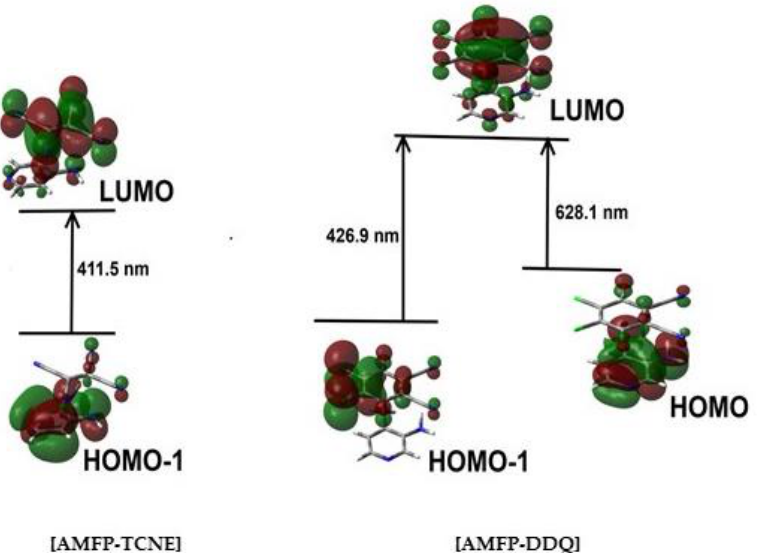
Figure 14. The molecular orbitals contributed to the electronic absorption of the AMFP–DDQ and AMFP–TCNE CT